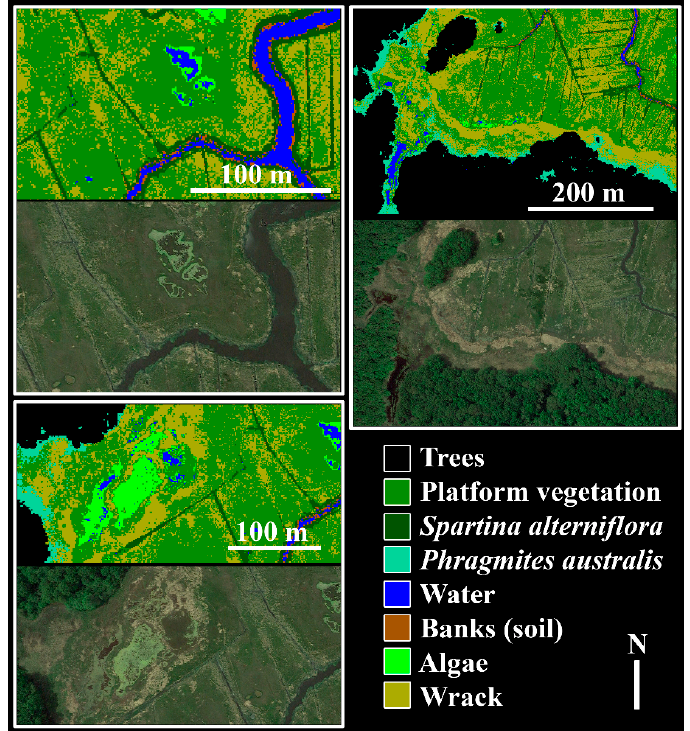
Figure 9 . Subsections of airborne lidar classification featured in Figure 8 from 10th June 2015, compared to aerial imagery from 6th June 2015. Aerial imagery source: Google.